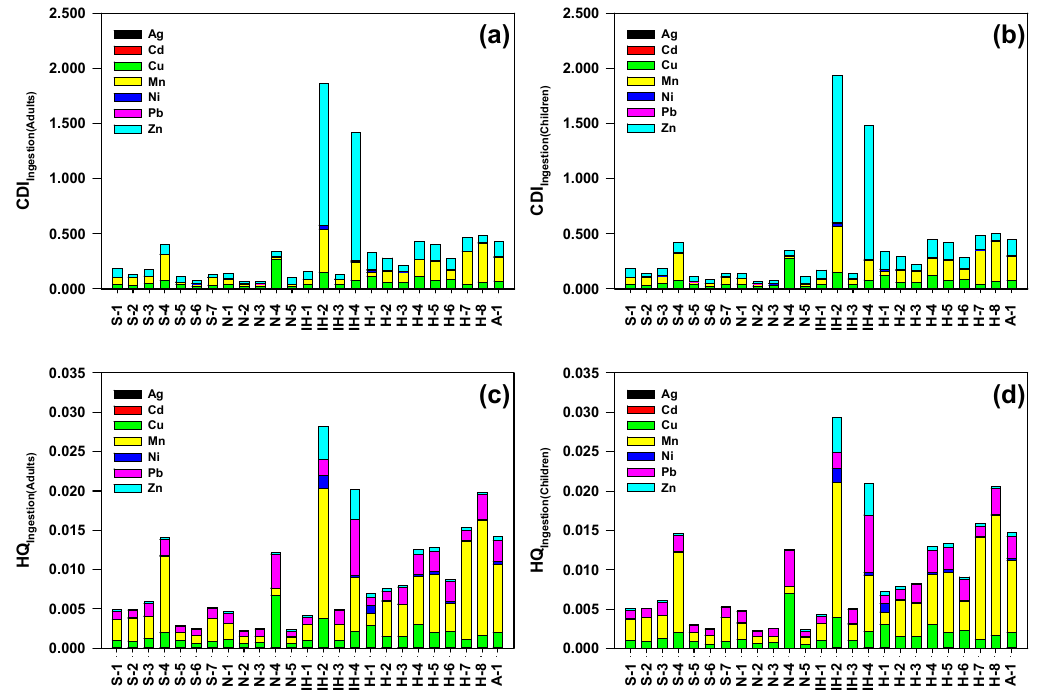
Figure 7. Variation of chronic daily intake (CDI) and hazard quotient (HQ) values for ingestion rate in ( a , c ) adult and ( b , d ) children population groups in the Han River watershed.